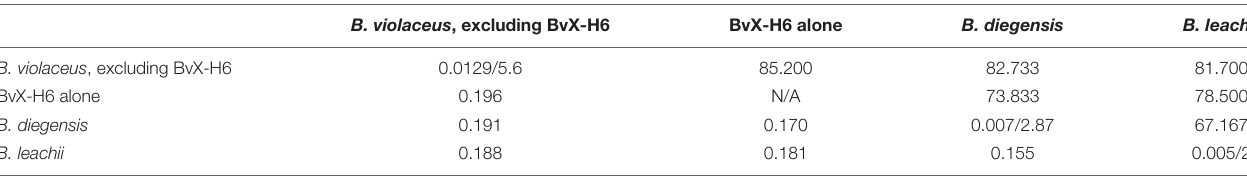
TABLE 2 | Estimates of average molecular divergence over haplotype pairs within and between taxonomic groups (i.e., the three accepted species, examining separately the haplotype